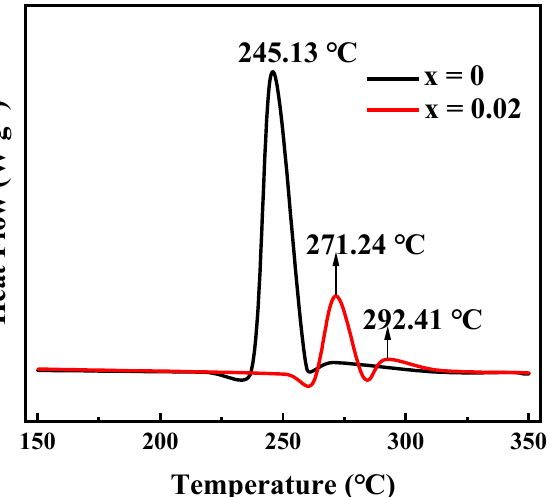
Figure 11. Differential scanning calorimeter (DSC) curves of Li[Ni 0.6 Co 0.2 Mn 0.2 ] 1 − x Ga x O 2 (x = 0, 0.02) charged to 4.3 V.